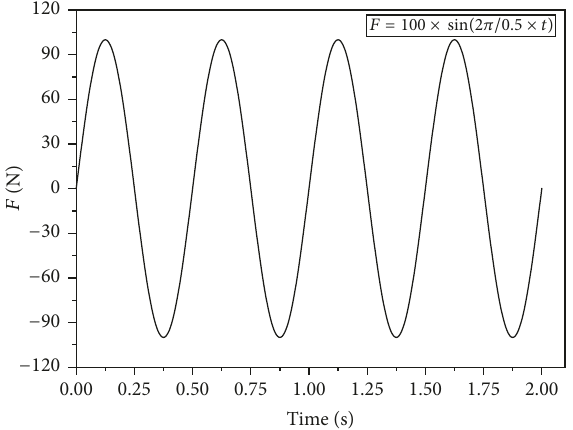
Figure 15: Sine-wave load at point 𝐴 of the BaTiO 3 FGMEE energy harvester.